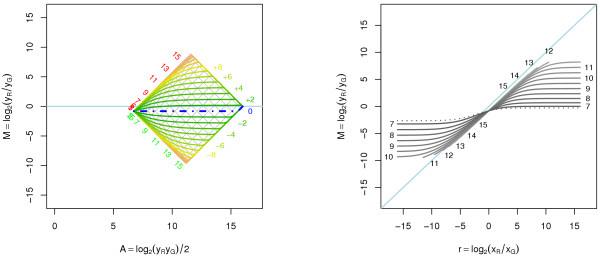
Perpendicular translation normalization of affine transformed data. Perpendicular translation normalization of A1
MathType@MTEF@5@5@+=feaafiart1ev1aaatCvAUfeBSjuyZL2yd9gzLbvyNv2CaerbwvMCKfMBHbqedmvETj2BSbWenfgDOvwBHrxAJfwnHbqeg0uy0HwzTfgDPnwy1aqee0evGueE0jxyaibaieYdOi=BH8vipeYdI8qiW7rqqrFfpeea0xe9Lq=Jc9vqaqpepm0xbbG8FasPYRqj0=yi0lXdbba9pGe9qqFf0dXdHuk9fr=xfr=xfrpiWZqaaeaabiGaaiaacaqabeaadaqacqaaaOqaaGWaaiab=bq8bnaaBaaaleaatCvAUfKttLearCWrP9MDH5MBPbIqV92AaGqbaiab+fdaXaqabaaaaa@43C0@ transformed data. The optimal amount of normalization shift in the raw data is a = 60, which corresponds to a′R
MathType@MTEF@5@5@+=feaafiart1ev1aaatCvAUfKttLearuWrP9MDH5MBPbIqV92AaeXatLxBI9gBaebbnrfifHhDYfgasaacH8akY=wiFfYdH8Gipec8Eeeu0xXdbba9frFj0=OqFfea0dXdd9vqai=hGuQ8kuc9pgc9s8qqaq=dirpe0xb9q8qiLsFr0=vr0=vr0dc8meaabaqaciaacaGaaeqabaqabeGadaaakeaacuWGHbqygaqbamaaBaaaleaacqWGsbGuaeqaaaaa@2F5C@ = 80 and a′G
MathType@MTEF@5@5@+=feaafiart1ev1aaatCvAUfKttLearuWrP9MDH5MBPbIqV92AaeXatLxBI9gBaebbnrfifHhDYfgasaacH8akY=wiFfYdH8Gipec8Eeeu0xXdbba9frFj0=OqFfea0dXdd9vqai=hGuQ8kuc9pgc9s8qqaq=dirpe0xb9q8qiLsFr0=vr0=vr0dc8meaabaqaciaacaGaaeqabaqabeGadaaakeaacuWGHbqygaqbamaaBaaaleaacqWGhbWraeqaaaaa@2F46@ = 140. Left: Log-ratios as a function of log-intensities for certain fold changes. The r = 1 curve (dot-dash blue) is horizontal, that is, for this specific value of r and a the log-ratios are independent of the log-intensities. Right: Normalized log-ratios versus true log-ratios. From this graph it is clear that we obtain the minimum error in log-ratios at zero-fold change. The dotted curves correspond to the minimum and maximum log-intensities possible to observe.